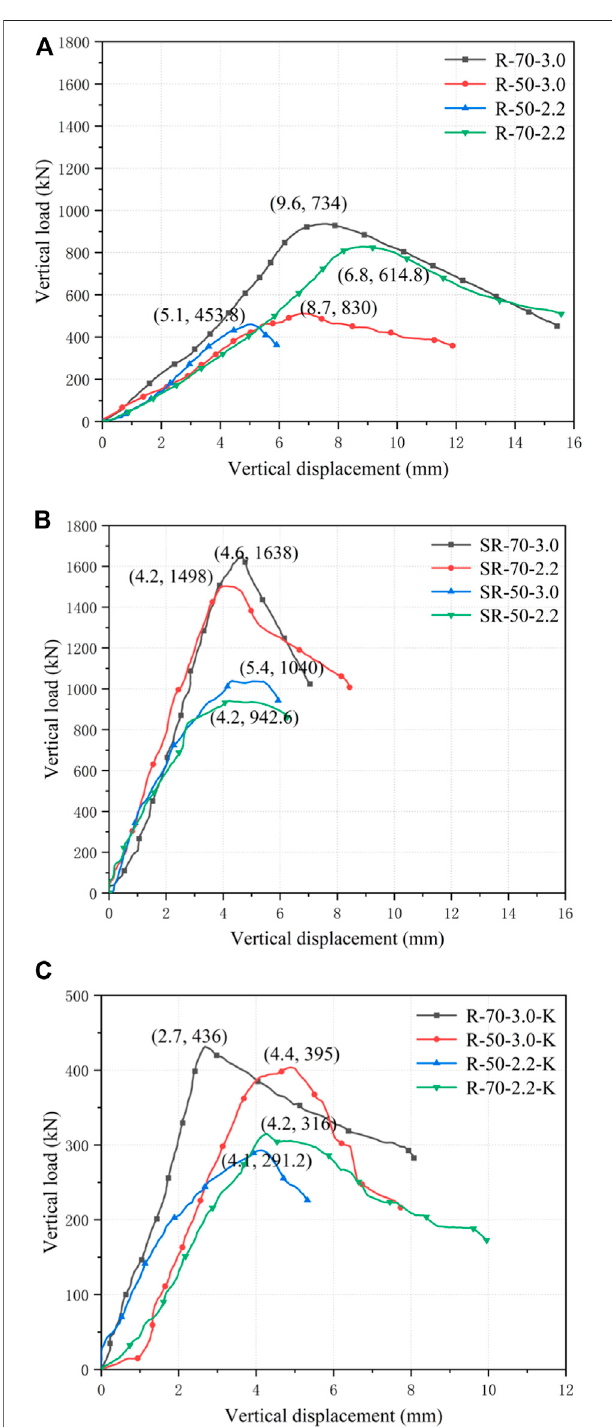
FIGURE 8 | (A) Single-limb specimens. (B) Double-limb specimens. (C) Hollow tubular